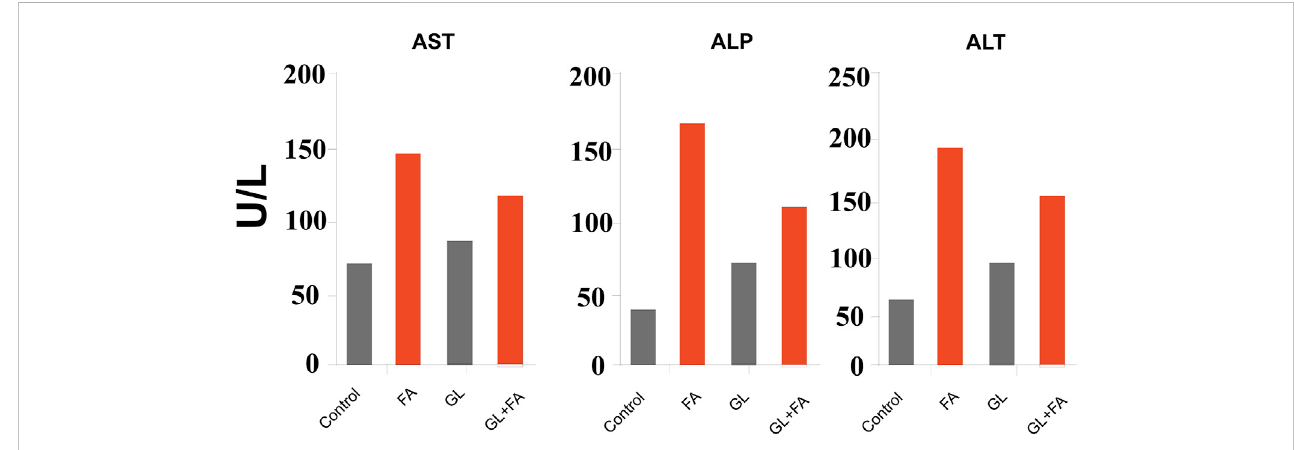
FIGURE 5 Data source:(OluwafemiAdetuyietal., 2020)formaldehydeandGL ’ seffect onhepatic enzymemarkers. Thedata aredisplayed asthemean ( n = 7).AST, aspartate aminotransferase; ALP, alkaline phosphatase; ALT, alanine aminotransferase.